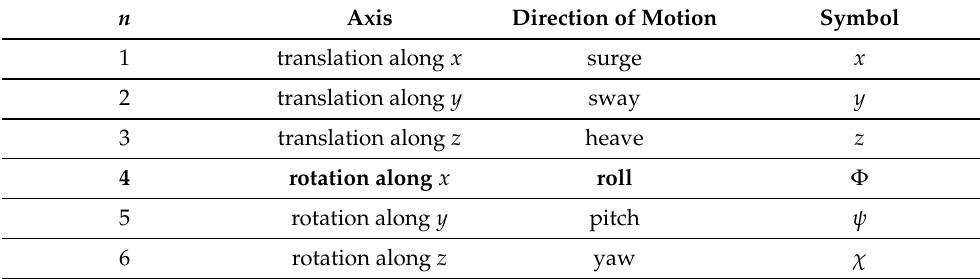
Table 1. Degrees of freedom for ship dynamics.